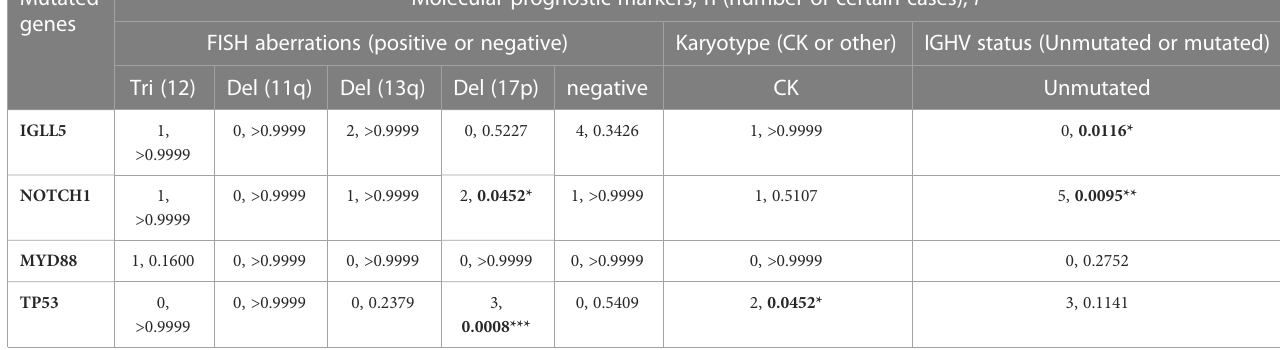
TABLE 4 Correlation of speci fi c gene mutations and molecular prognostic markers. Mutated Molecular prognostic markers, n (number of certain cases), P genes FISH aberrations (positive or negative) Karyotype (CK or other) IGHV status (Unmutated or mutated)